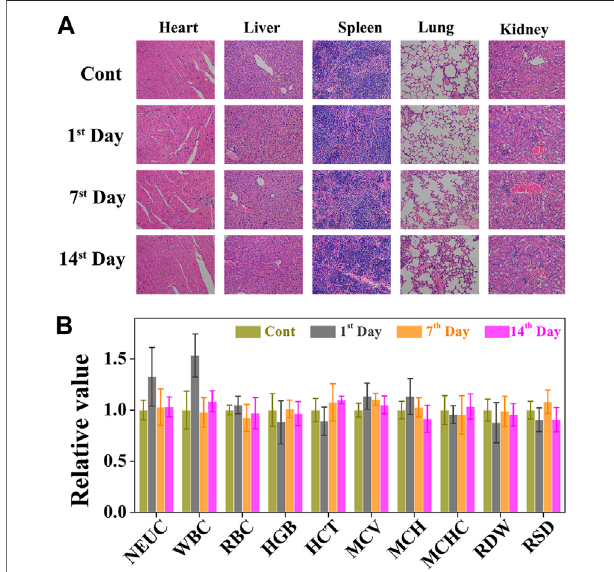
FIGURE 8 | (A) The cytotoxic effect caused by CO&Dox@NPs with irradiation in major organs via H&E staining (heart, liver, spleen, lung, and kidney). (B) Serum biochemical study and hematology assay of neutrophilic granulocyte (NEU), white blood cell (WBC), red blood cells (RBC), hemoglobin(HGB),hematocrit(HCT),meancorpuscularvolume(MCV),mean corpuscularhemoglobinconcentration(MCH),meancorpuscularhemoglobin concentration (MCHC), coef fi cient variation of red cell distribution (RDW), and standard deviation in red cell distribution (RSD) levels at 1, 7, and 14 days.